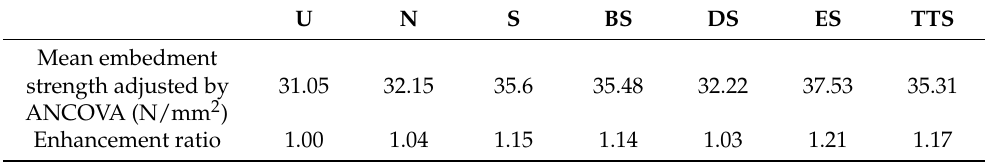
Table 3. Results of embedment strength analysed by ANCOVA [31]. U